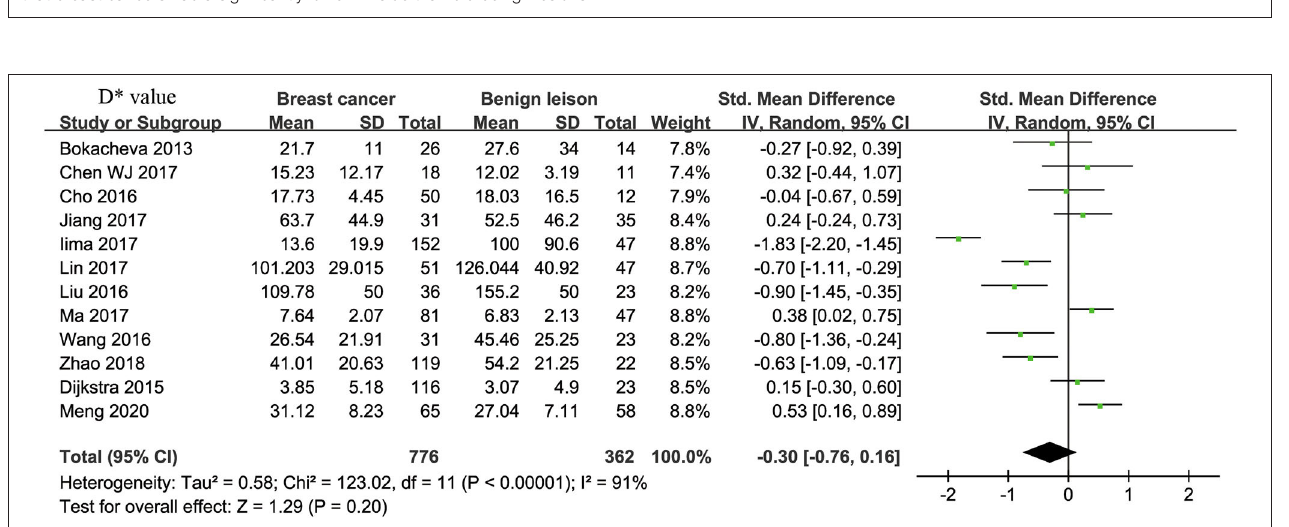
Frontiers in Oncology |